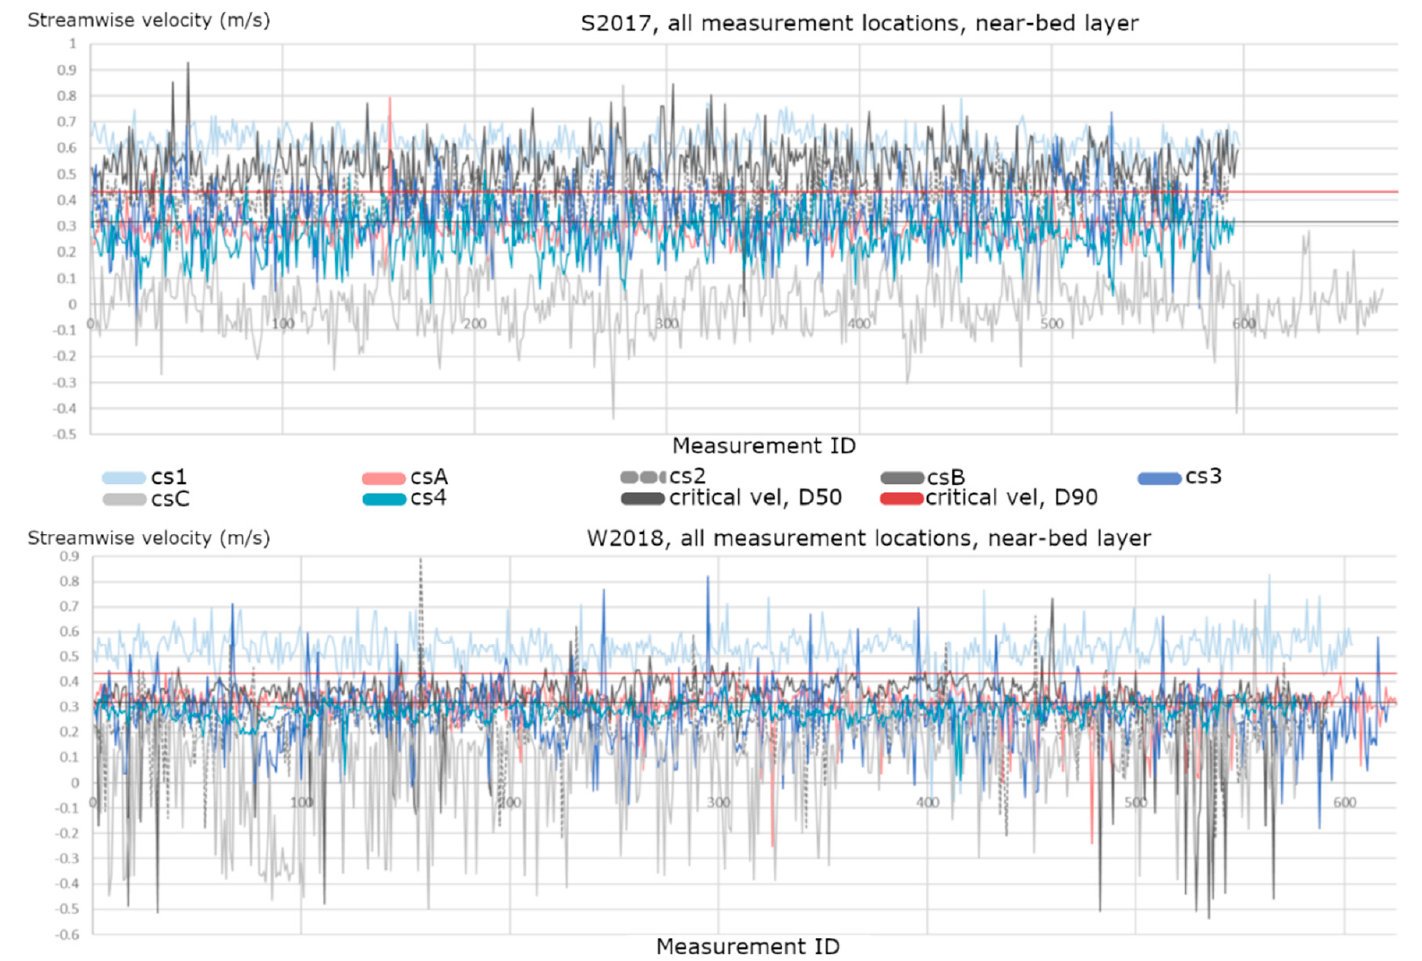
Figure 9. The streamwise velocity (m / s) of the deepest cells at all measurement locations on W2018 (mid-winter ice-covered flow conditions) and S2017 (spring snow-melt flow conditions). The critical velocity thresholds for the movement of the largest measured D50 and D90 grain sizes are shown. Note that the deepest cells are at different depths depending on the measurement